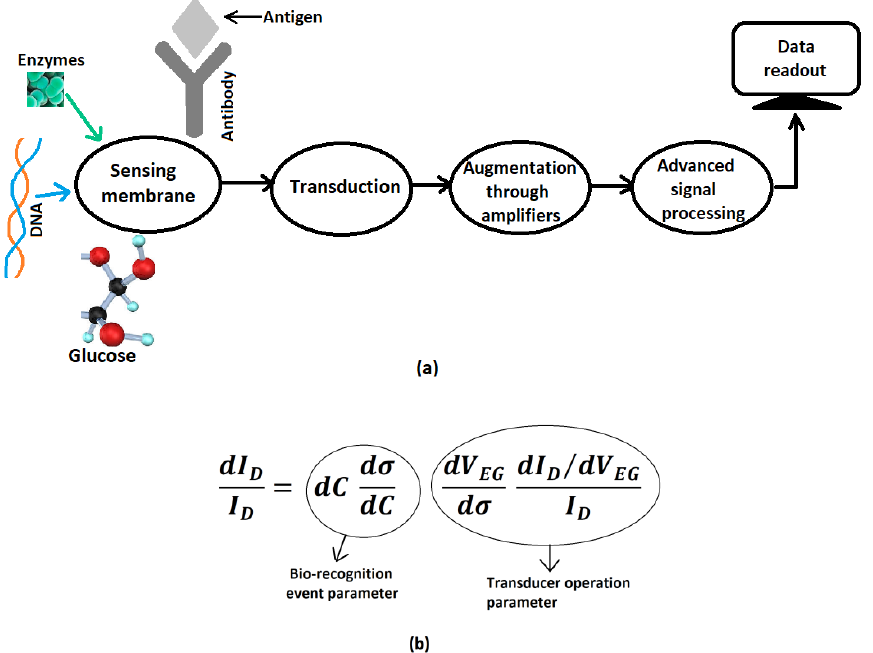
Figure 1. ( a ) A schematic representation of the working of a biosensor; ( b ) sensitivity formulation of biosensor depending on bio-recognition event parameter and transducer operation.